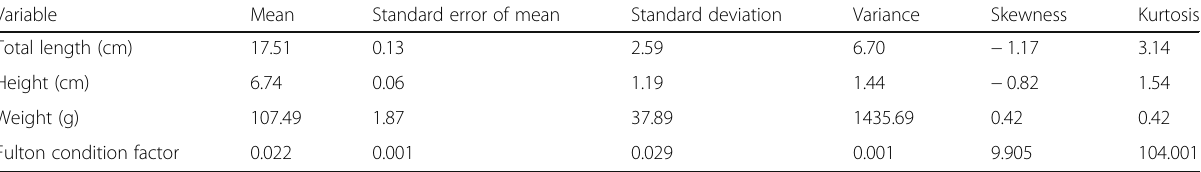
Table 1 Descriptive statistics of the biometric data of Coptodon zillii Variable Mean Standard error of